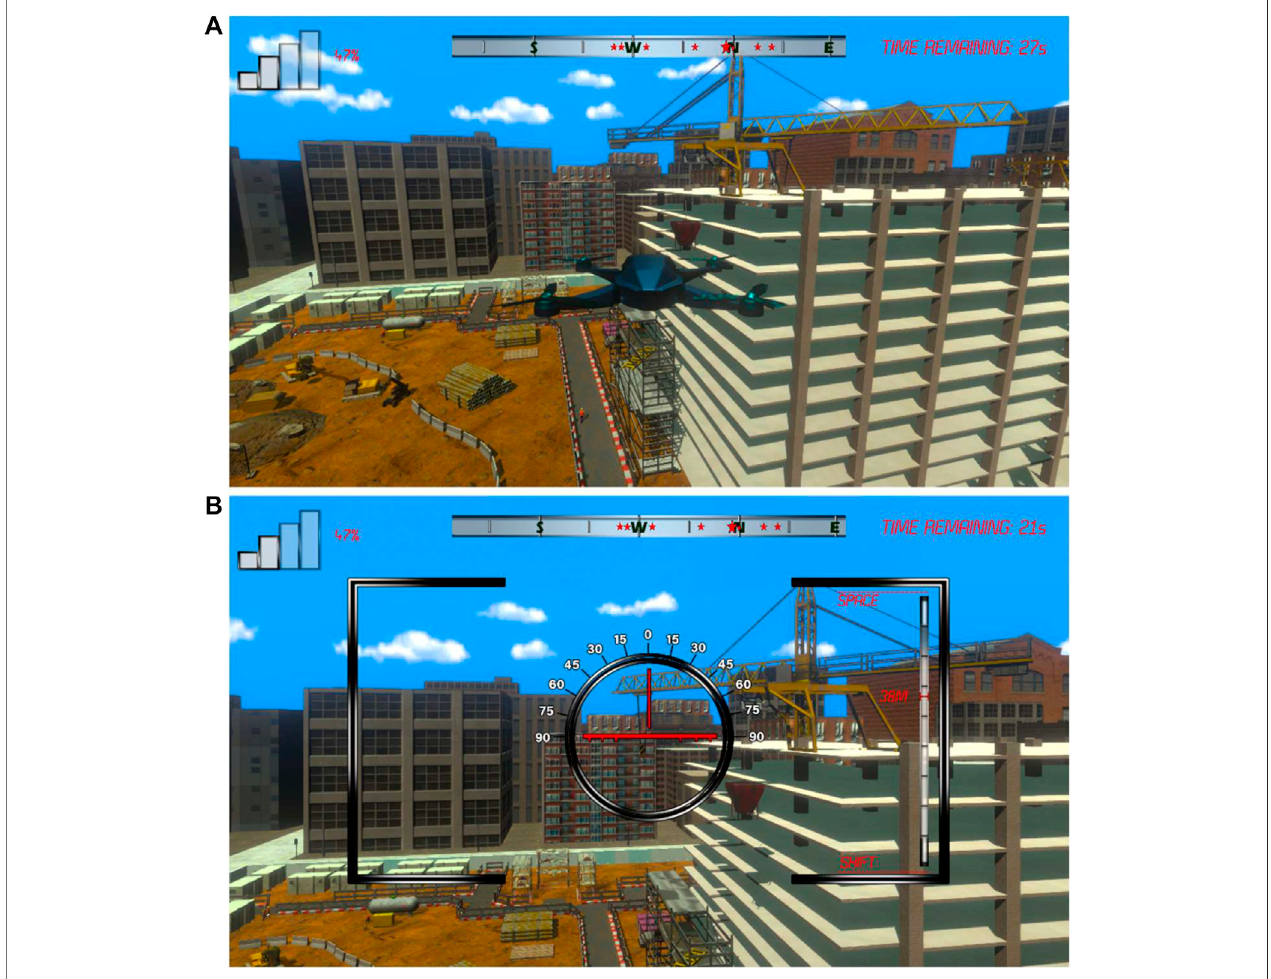
FIGURE 2 | (A) image shows the third person viewpoint and (B) image show the on-board camera viewpoint when piloting the drone.